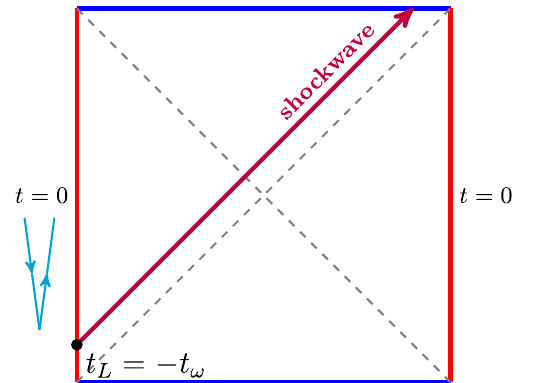
Fig. 10 Intheabsenceoftheshockwavethesizeofthemaximalspace- like slice formed behind the horizon is null (it goes through the inter- section point of the bifurcate horizon). Adding the shockwave allows the maximal slice to acquire a considerable volume as indicated by the red